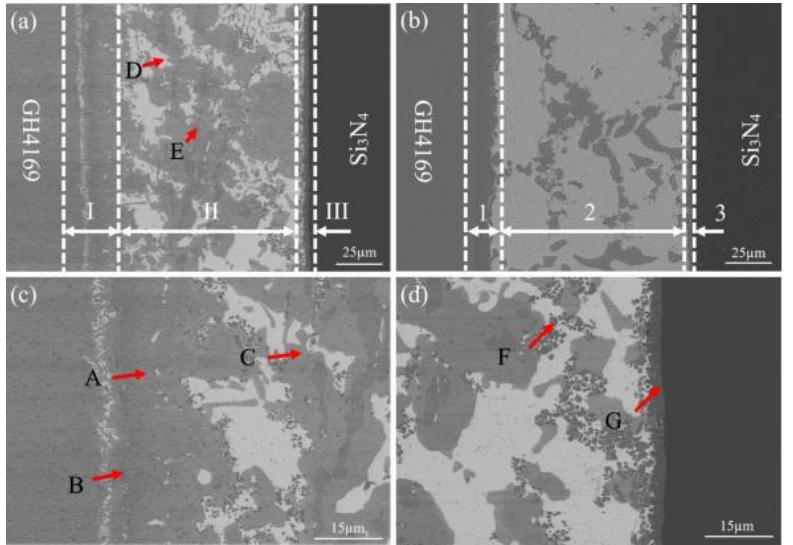
Figure 5. Microstructure of the GH4169/Si 3 N 4 joint brazed at 850 °C for 15 min: ( a ) the joint brazed with Cu foam; ( b ) the joint brazed without Cu foam; ( c ) high magnification image of the zone I; ( d ) high magnification image of the zone III.